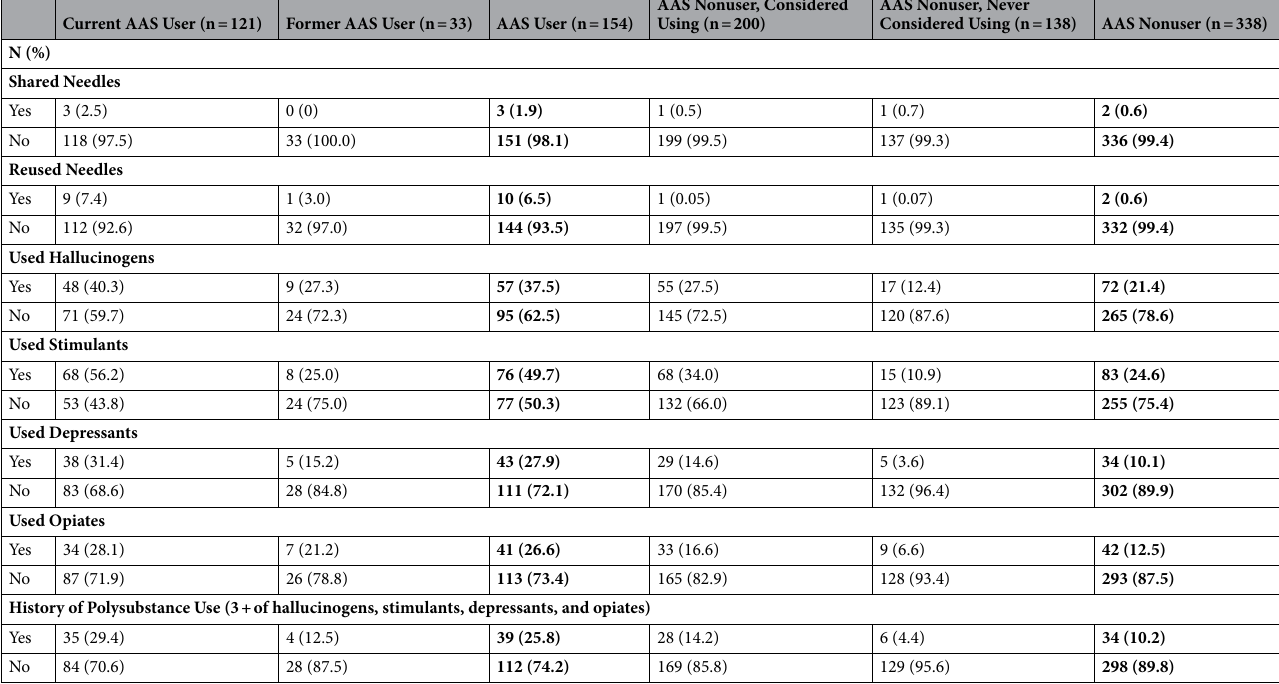
Table 3. Substance use risk-taking behaviors by AAS use status. Overall columns for primary analysis (AAS User, AAS Nonuser) are in